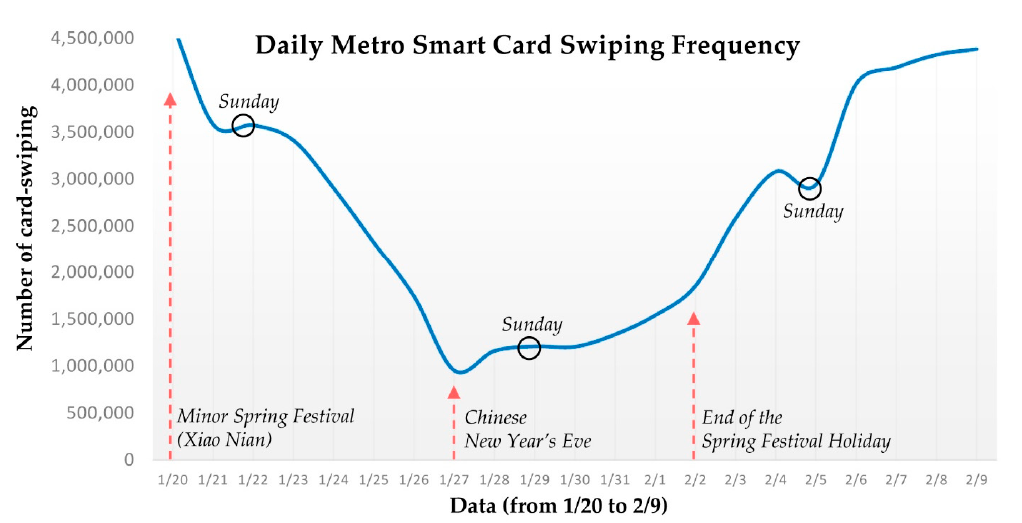
Figure 8. Daily metro smart card swiping frequency of 21 days.